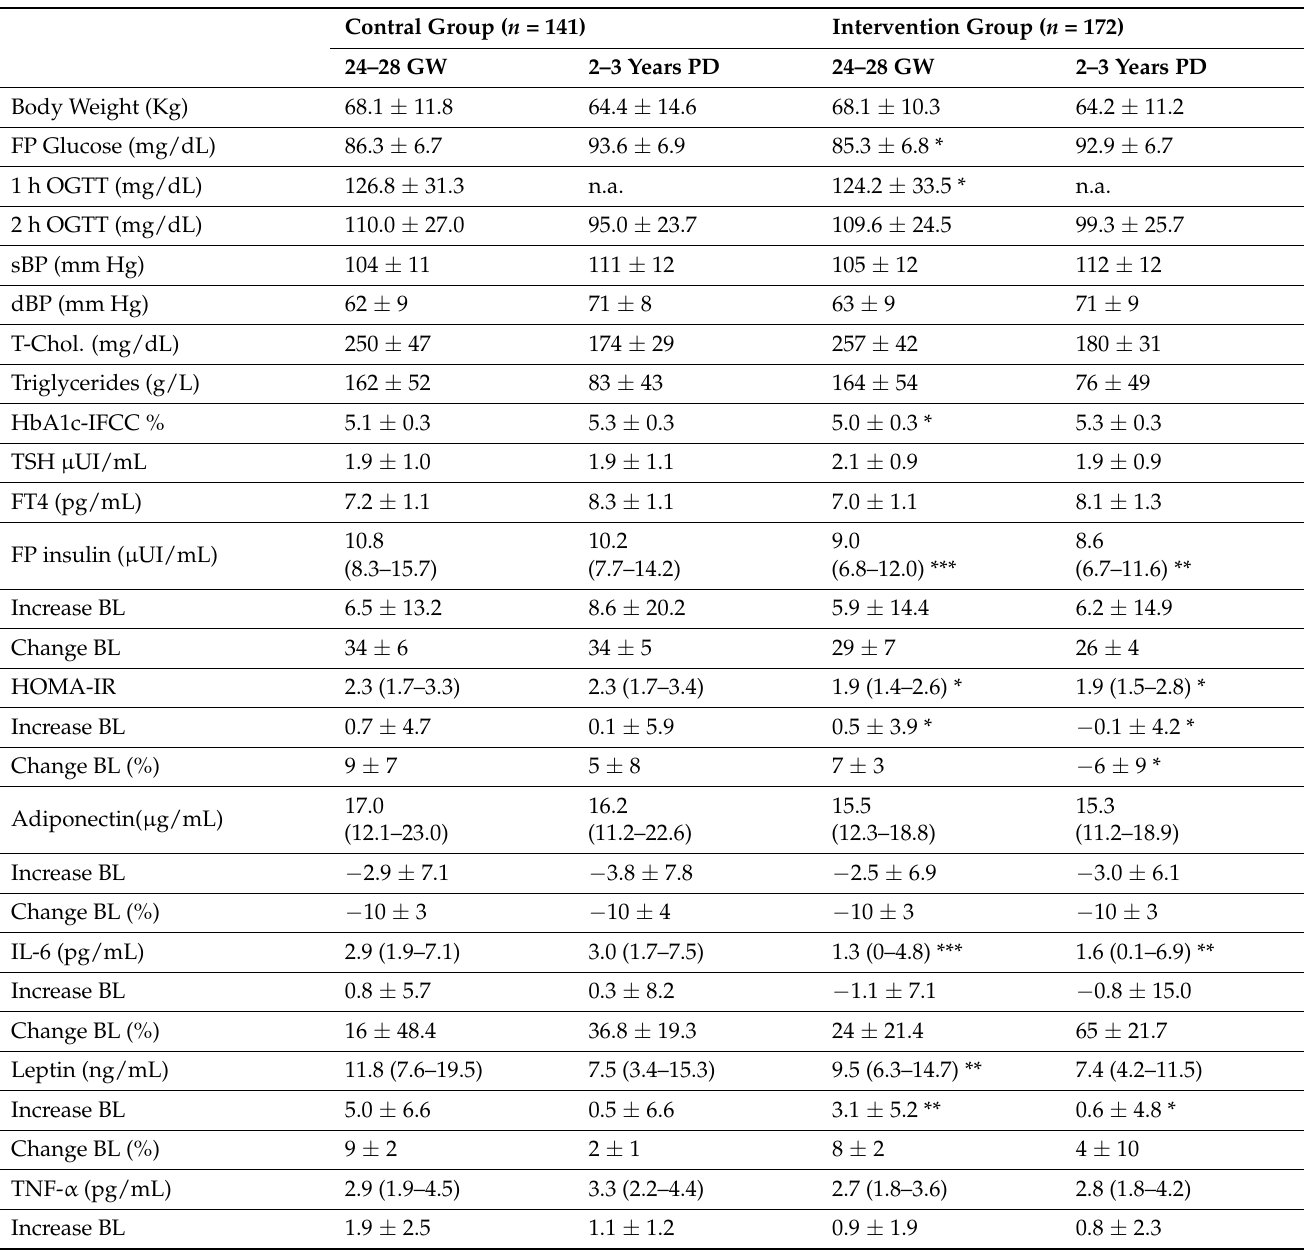
Table 5. Clinical and laboratory during pregnancy and 2–3 years post-delivery data by